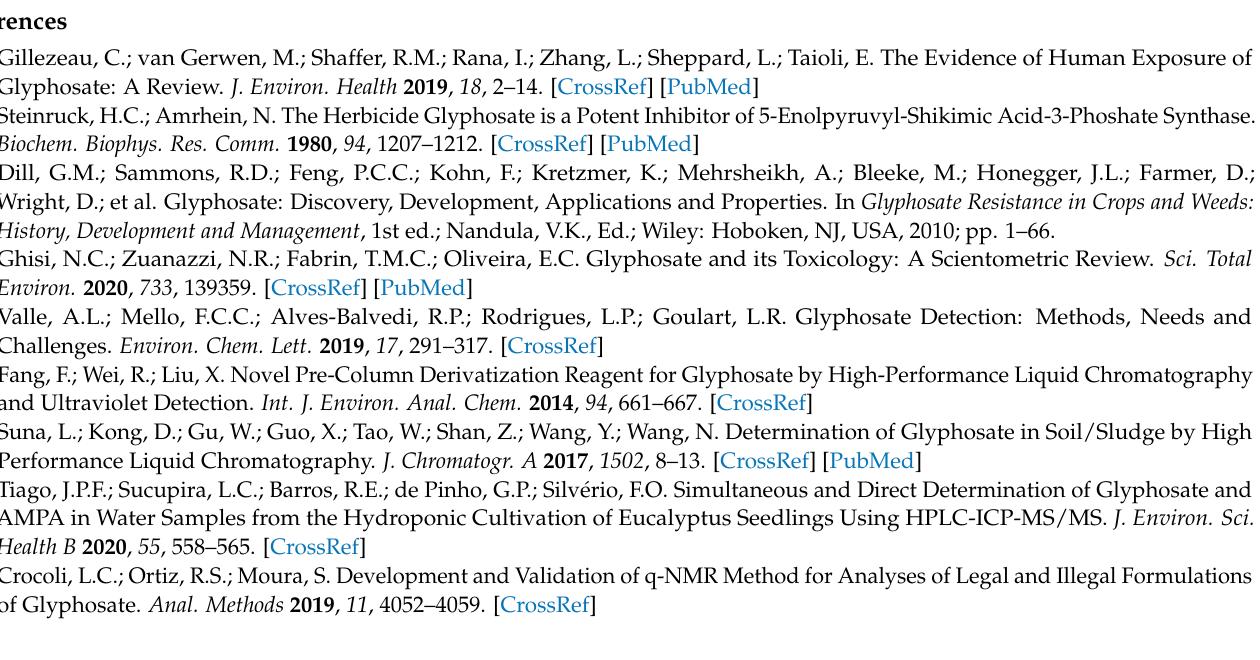
Figure S4 (Emission spectra of [Cu(opba)] 2 − -(GLY)-1,2,4 complexes at 270 nm and 350 nm excitations), Table S1 (Assignment of FTIR and Raman bands for [nBu4N]2[Cu(opba)]).